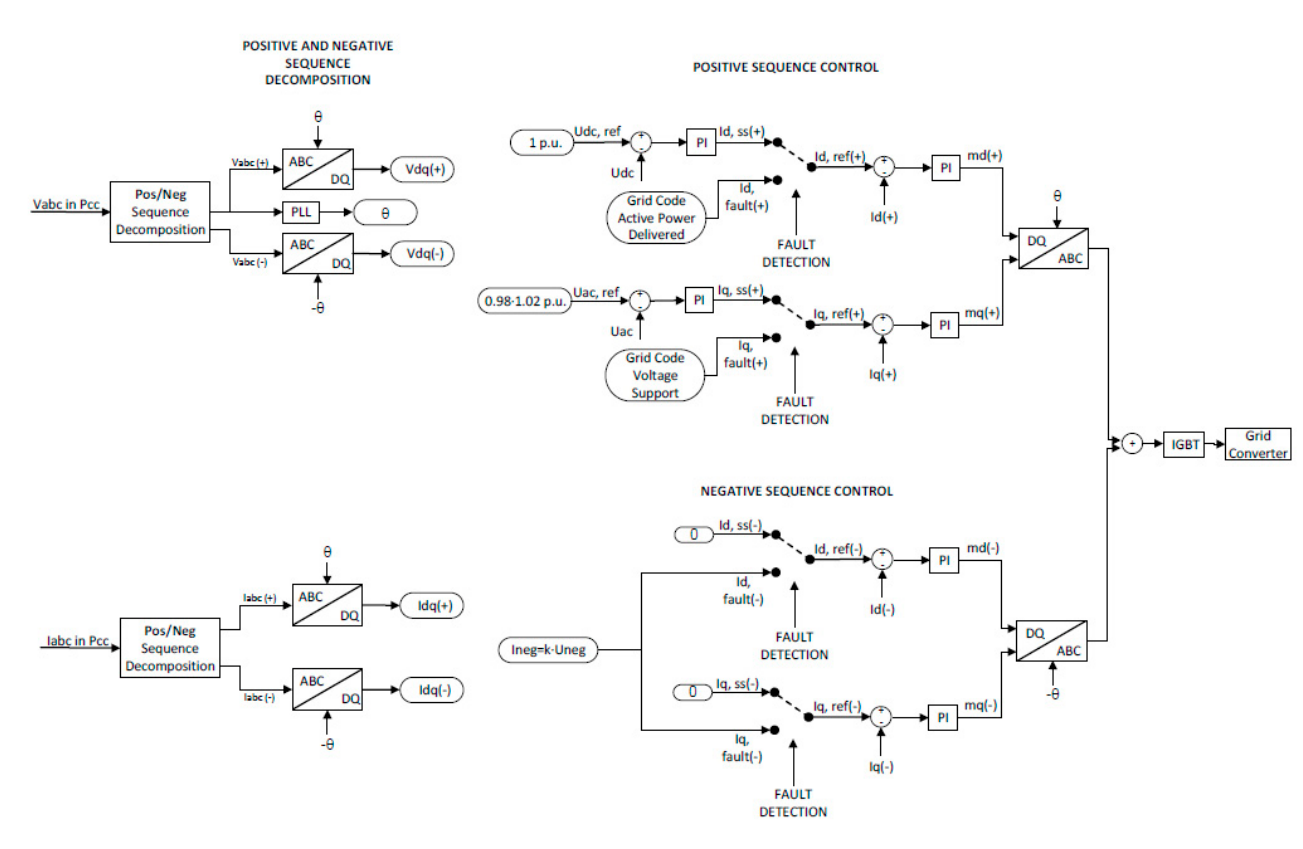
Figure 7. Schematic control diagram.